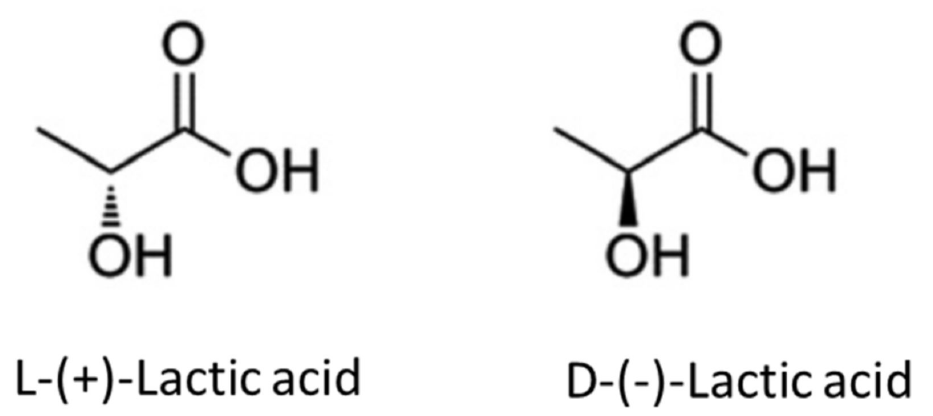
Figure 1. Chemical structure of lactic acid stereoisomers: L-(+)-lactic acid is also known as (S)-lactic acid and D-( − )-Lactic acid, also known as (R)-lactic acid, adapted from